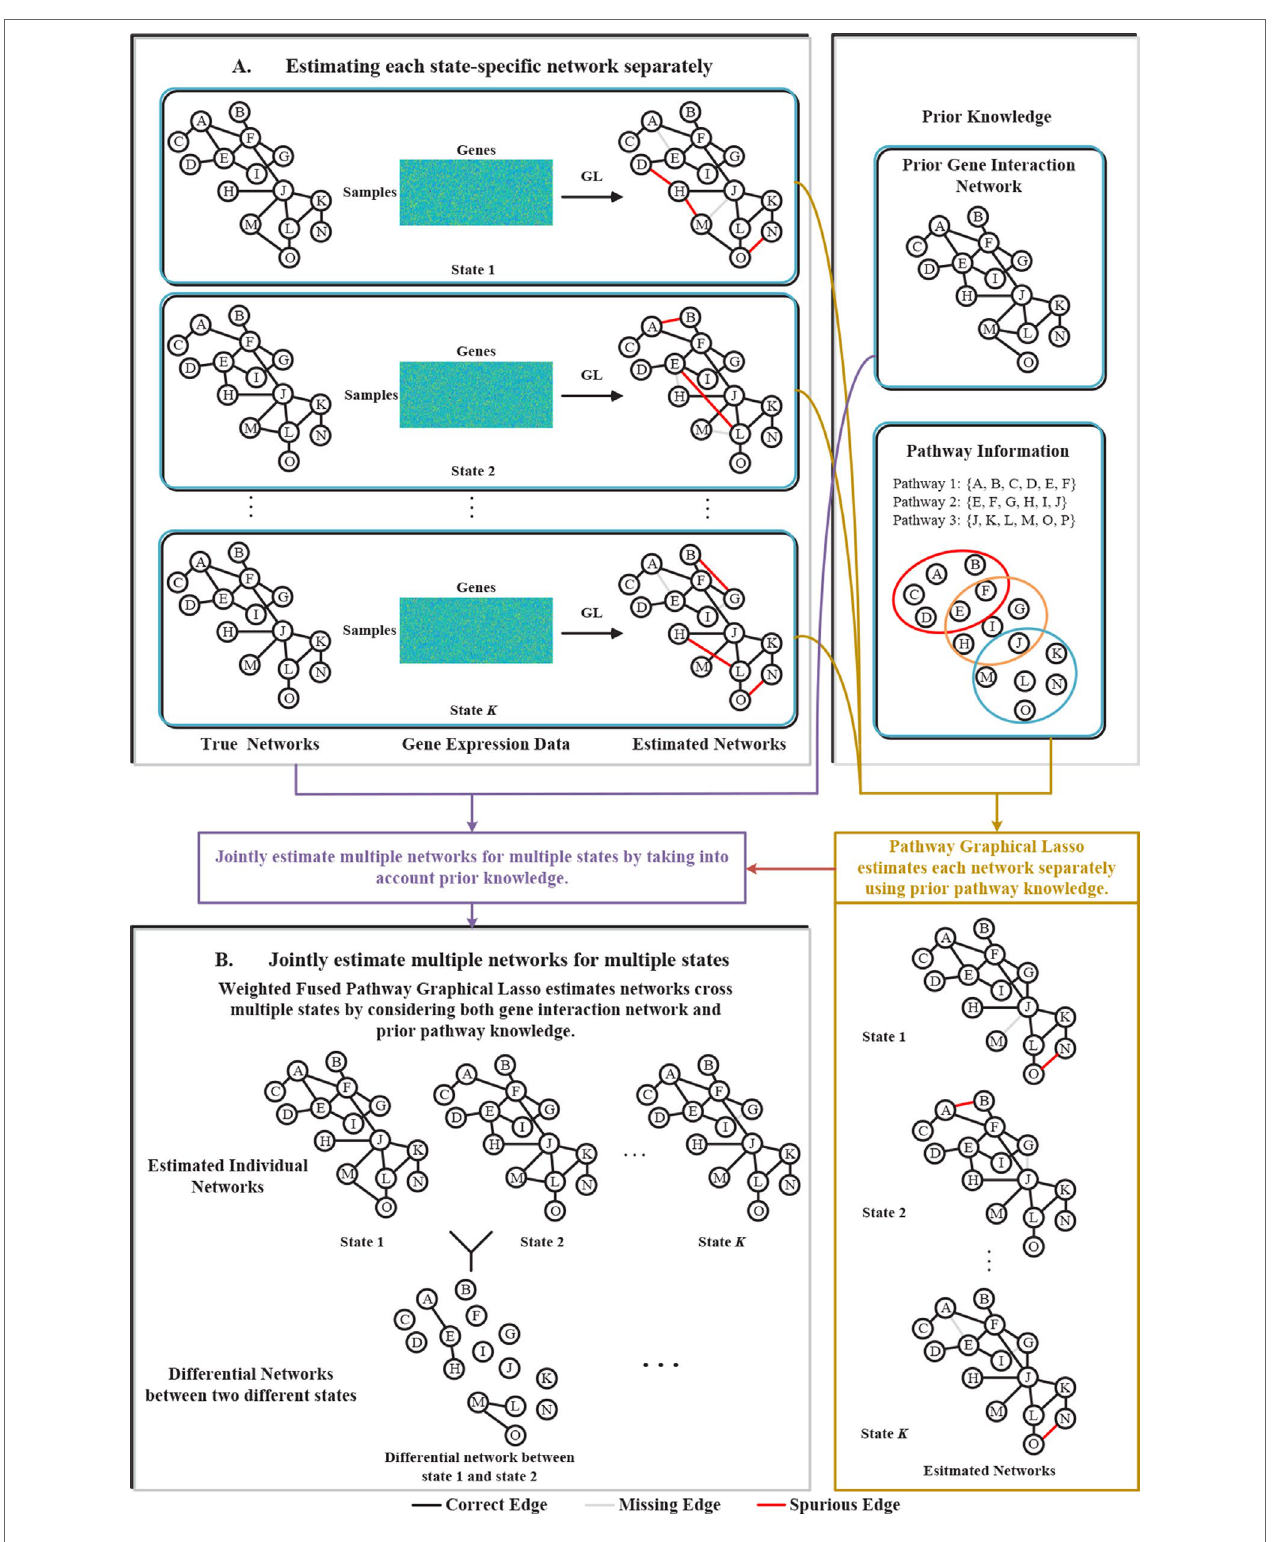
FIGURE 1 | Illustration of the proposed method. (A) Graphical lasso just uses gene expression data to separately estimate each state-specific network, leading to incorrect estimation results. (B) The proposed weighted fused pathway graphical lasso jointly estimates multiple state-specific networks by considering the prior knowledge of gene interaction networks and pathways, which could eliminate the spurious links between different pathways and results in more accurate estimation of the networks across multiple